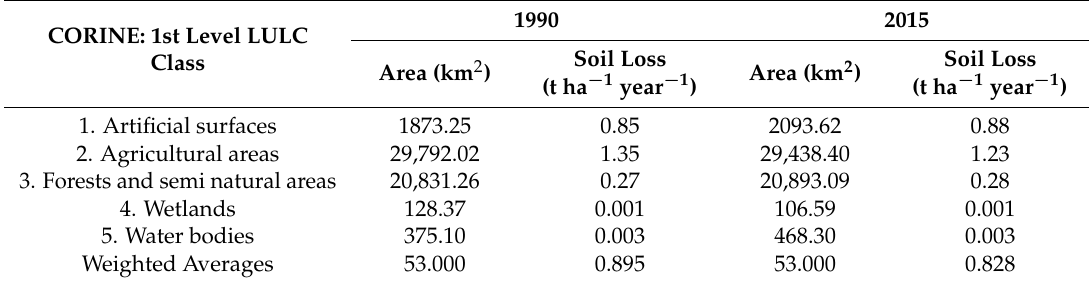
Table 3. The average annual soil loss for each LULC classes and weighted averages in 1990 and